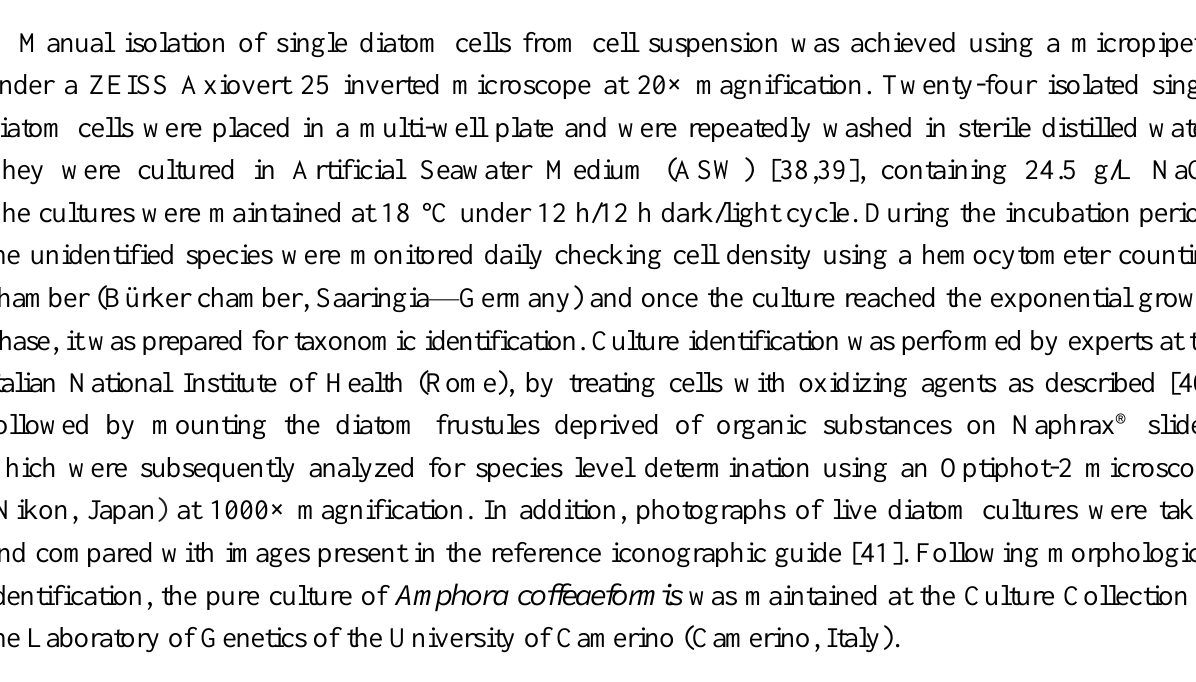
Figure 1. Map of the sampling site along Tyrrhenian coast of Lazio Region; The white arrow indicates the site of Foce Verde (41°24.937'N Latitude; 12°48.755'E Longitude) where the estuarine water was